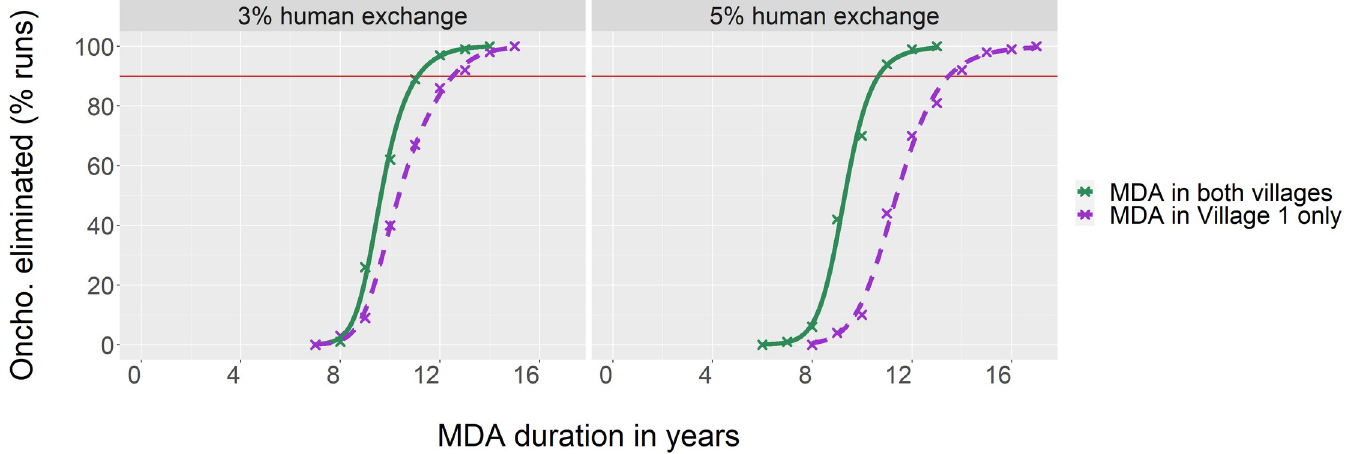
Fig 5. Impact of MDA strategy on the probability of onchocerciasis elimination for situations with villagers on average spending respectively 3% or 5% of their time in the non-home village. ABR Village 1 = 16,000, ABR Village 2 = 8,000. Crosses represent the proportion of runs with onchocerciasis eliminated at 100 years post MDA; lines are logistic fits to these